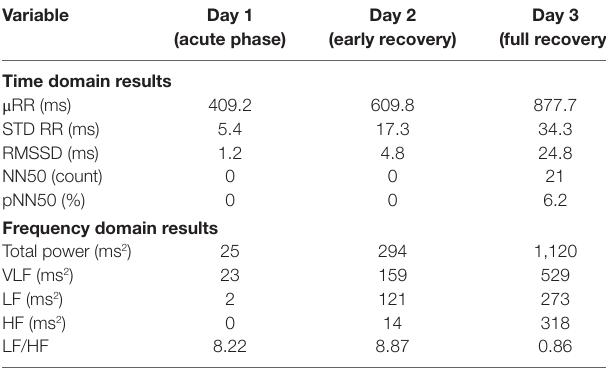
tabLe 2 | Time domain and frequency domain